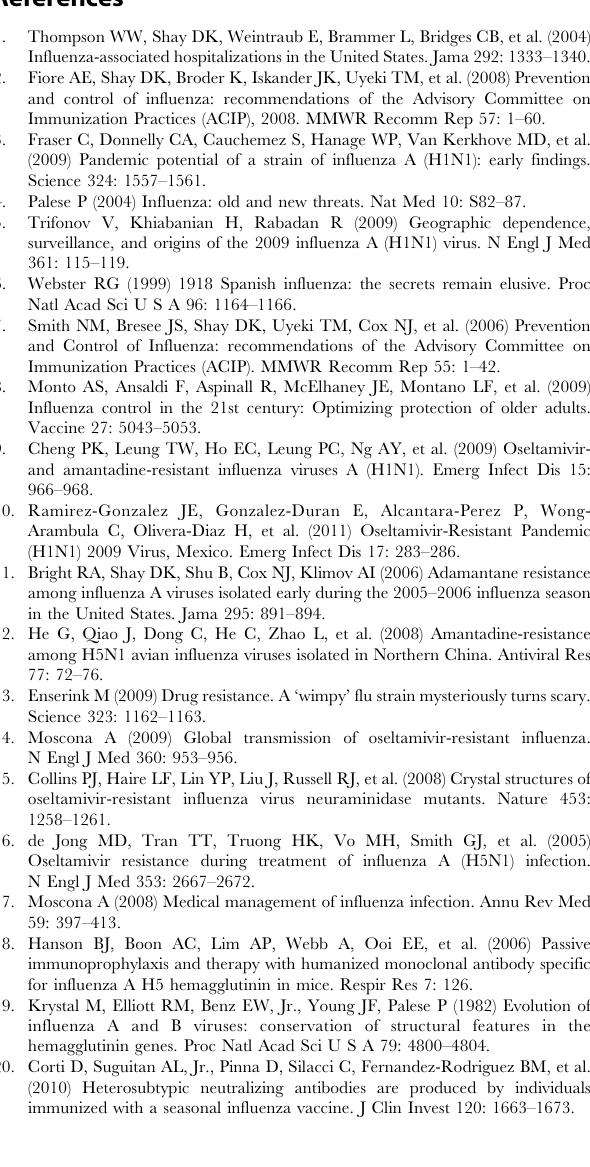
Table S1 Major anti-influenza human monoclonal antibodies with heterosubtypic neutralizing activity.